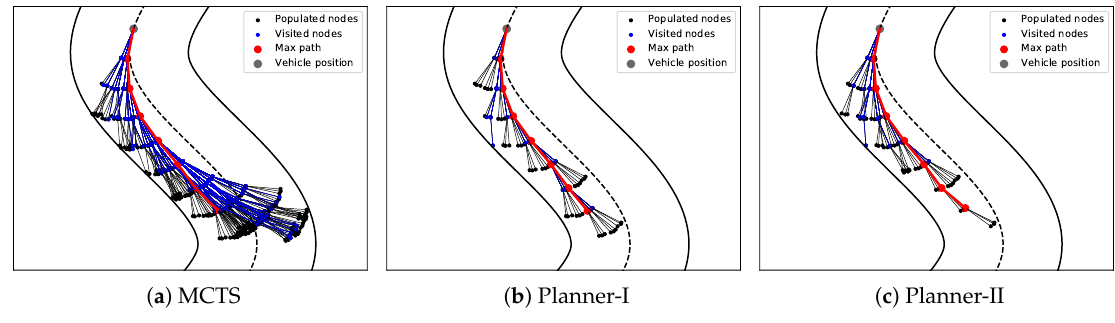
Figure 10. Search trees built by different